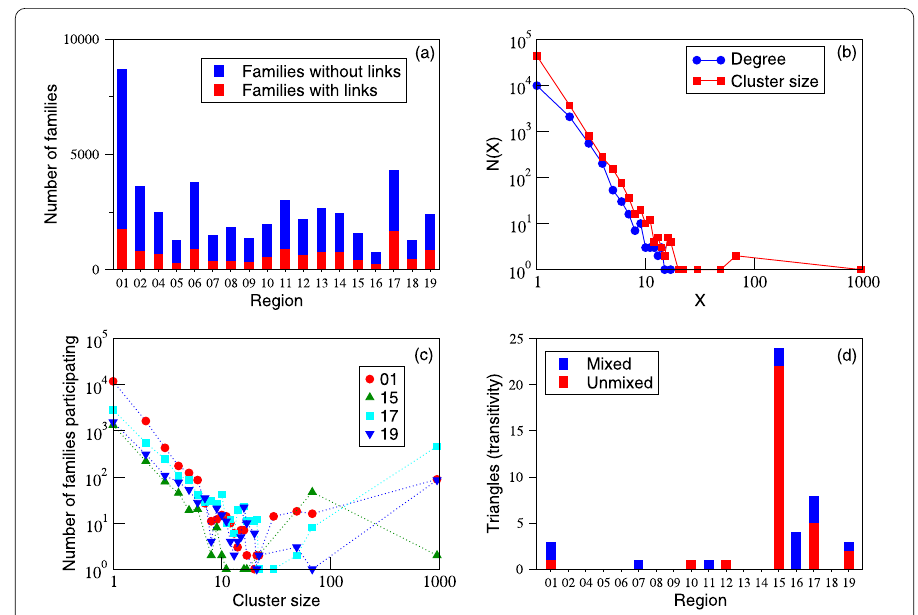
Figure 3 Characteristics of the network. ( a ) Number of families distributed over the 18 regions of mainland Finland. The plot shows the number of families that could be linked to other families in comparison with the total number of families. ( b ) The degree distribution of the network (circles) and the distribution of sizes of connected components or clusters (squares). ( c ) Participation in the different connected components by families from different regions (four cases illustrated). ( d ) Number of transitive triangles that each region participates in. In an ‘Unmixed’ case, the triangle is solely composed of families belonging to the particular region of origin; and in a ‘Mixed’ case the triangle comprises of families from different regions with at least one belonging to the particular